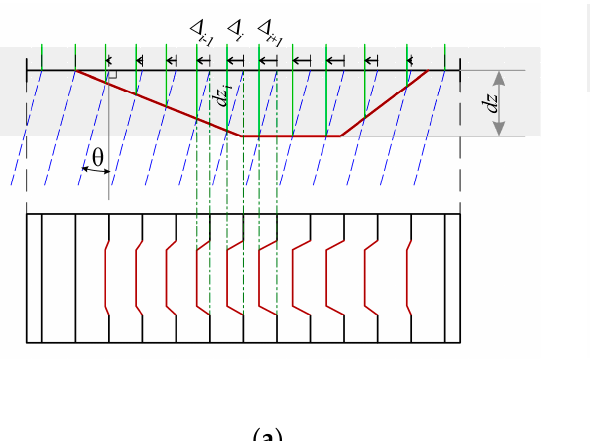
Figure 12. Pro fi les of the central region of the depth map: blue—initial (Figure 2d), green—restored by the hologram (Figure 8), red—restored by SLFP (Figure 10); ( a ) for clarity, the pro fi les are shifted along the vertical direction; ( b ) the pro fi les are combined.